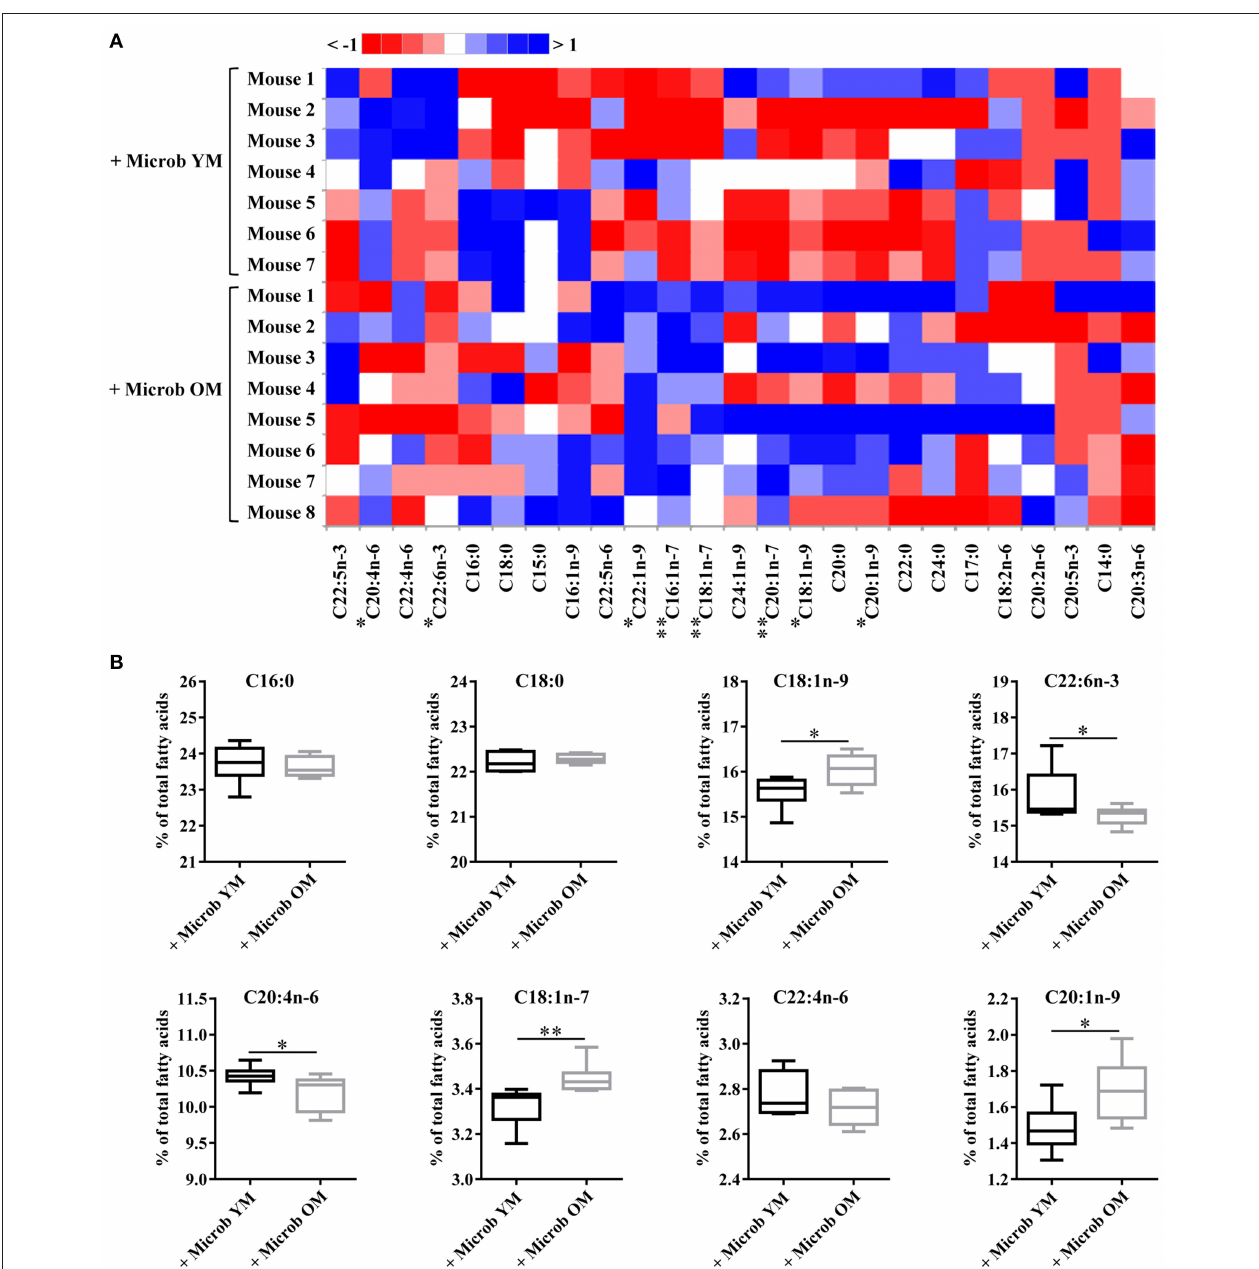
FIGURE 3 | Ester-linked fatty acid profile in the cortex of mice inoculated with different age-related microbiota. Lipids were extracted from the cortex of mice inoculated with fecal microbiota of young mice ( + Microb YM) or old mice ( + Microb OM). The results correspond to quantification of fatty acid methyl esters (FAME) derivatives by GC-FID. The percentage of each fatty acid relative to that of total fatty acids (100%) was determined. (A) Heat map showing the abundance of each fatty acid relative to total fatty acids, defined as 100% (B) Relative abundance of the eight most abundant fatty acids quantified in the brain. All data are presented as mean ± SEM. n = 7 for the group of mice inoculated with the microbiota of young mice and n = 8 for the group of mice inoculated with the microbiota of old mice. Comparisons were done between the two groups of mice ( + Microb YM and + Microb OM). * p < 0.05 and ** p < 0.01.